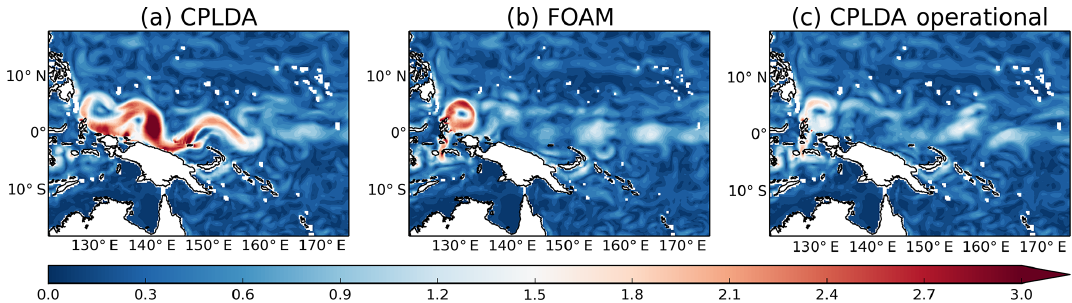
Figure 12. 15m velocity average (ms − 1 ) in the western tropical Pacific for the week from 5 to 11 November 2015 for (a) CPLDA, (b) FOAM and (c) CPLDA with the current operational scheduling, allowing for the assimilation of additional SLA observations. Table 2. Velocity class 4 statistics against drifting buoys for 2015 (ms − 1 ). Model CPLDA FOAM PSY4 Bias RMSE Correlation Bias RMSE Correlation Bias RMSE Correlation Global − 0 . 07 0.19 0.50 − 0 . 07